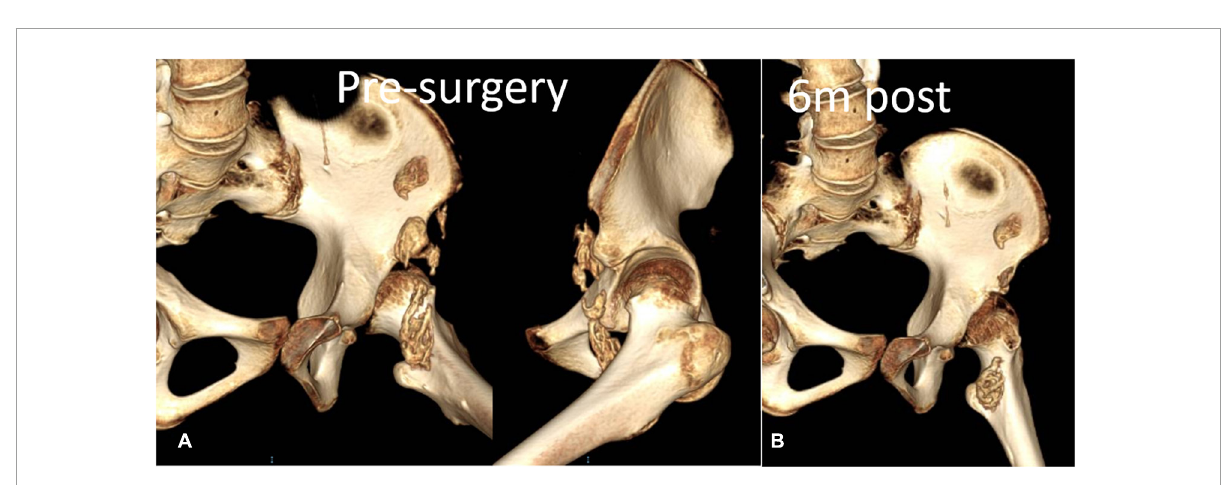
FIGURE7 Anteroposterior view of the Computed tomography scan of the left hip confirmed aforementioned findings and additionally revealed heterotopic ossification of the iliopsoas muscle. (A) Preoperative CT reconstruction. (B) 6-month follow-up.